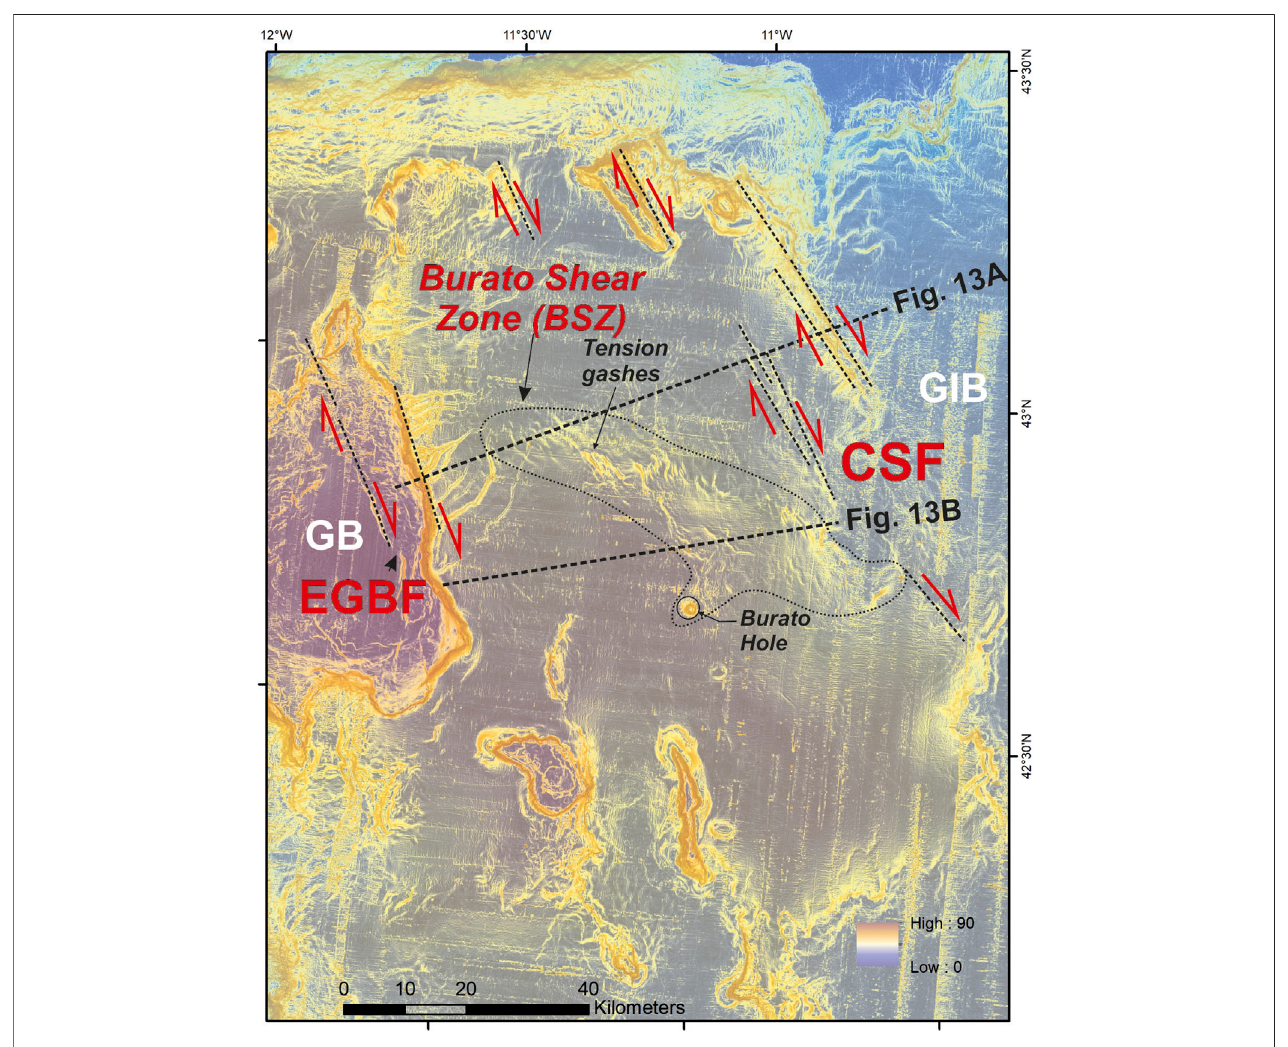
FIGURE 12 | Slopegradientmapofthe high-resolution bathymetryoftheBuratoShear Zone(BSZ)between theGalicia Bank(GB) and theGaliciaInteriorBasin(GIB). Seismic pro fi les shown in Figure 13 are also displayed. This shear zone is located between two main systems of NNW-SSE fault systems acting as right-lateral strike-slip system, i.e., the Castelao fault (CSF) and the East Galicia Bank fault (EGBF). Other labels same than in Figure 9 . See also Figure 10 for location of the Burato Shear Zone.